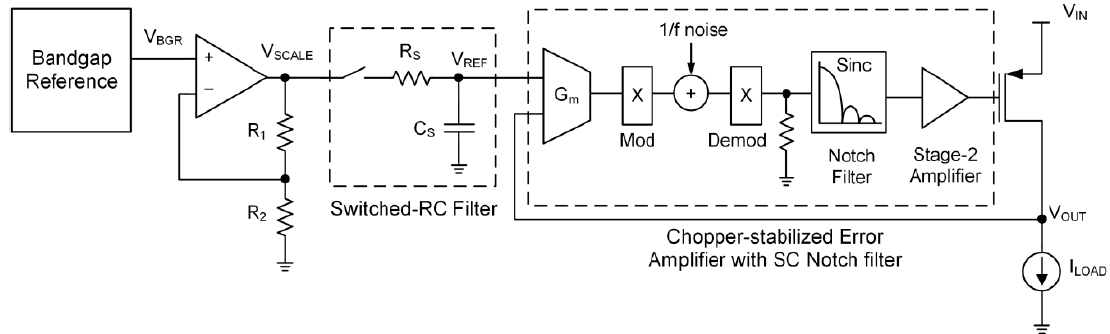
Figure 22. Switched RC Bandgap Reference ALDO [50].